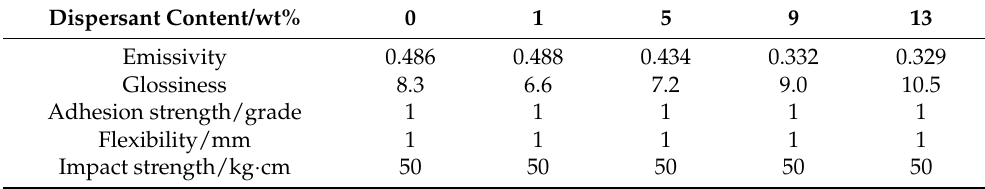
Table 4. Performance index of coatings with different addition amounts of dispersant.